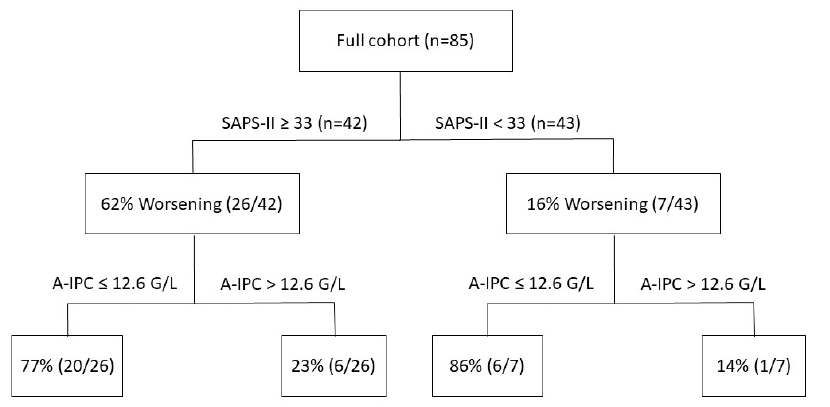
Figure 4. Repartition of patients according to SAPS-II severity score values and absolute immature platelet counts and their respective evolution during their ICU stay (worsening or not worsening).